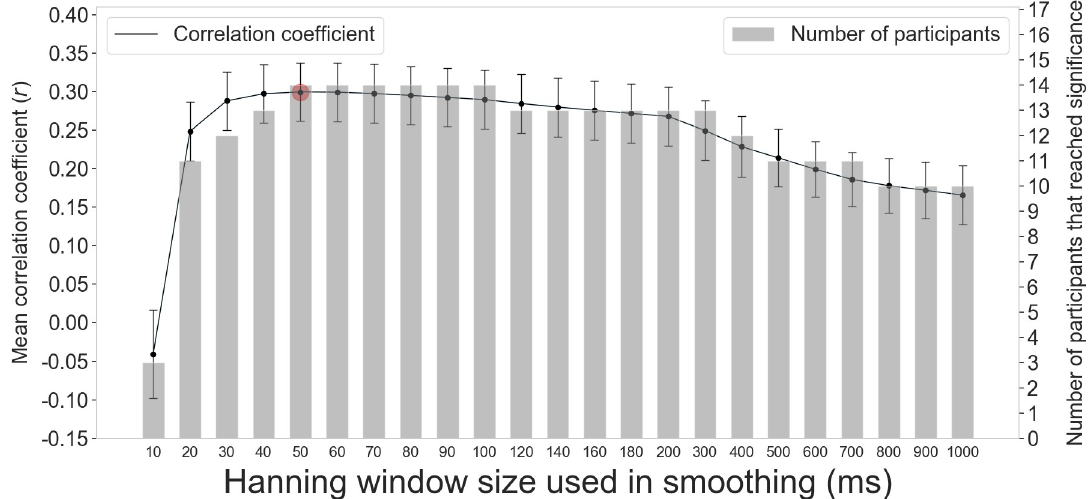
Fig 7. Mean correlation coefficients between normalized M-PUI and normalized RT for each Hanning window size and numbers of participants whose correlation coefficient reached significance. Red dots indicate the points where detailed scatterplots are shown in Fig 6. Error bars represent standard errors.